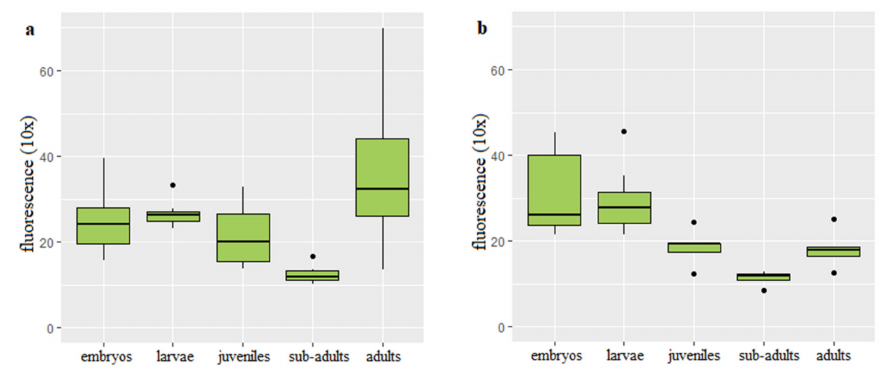
Figure 2. Telomere length-related fluorescence reported in diploid ( a ) and triploid ( b ) rainbow trout at di ff erent stages of development.